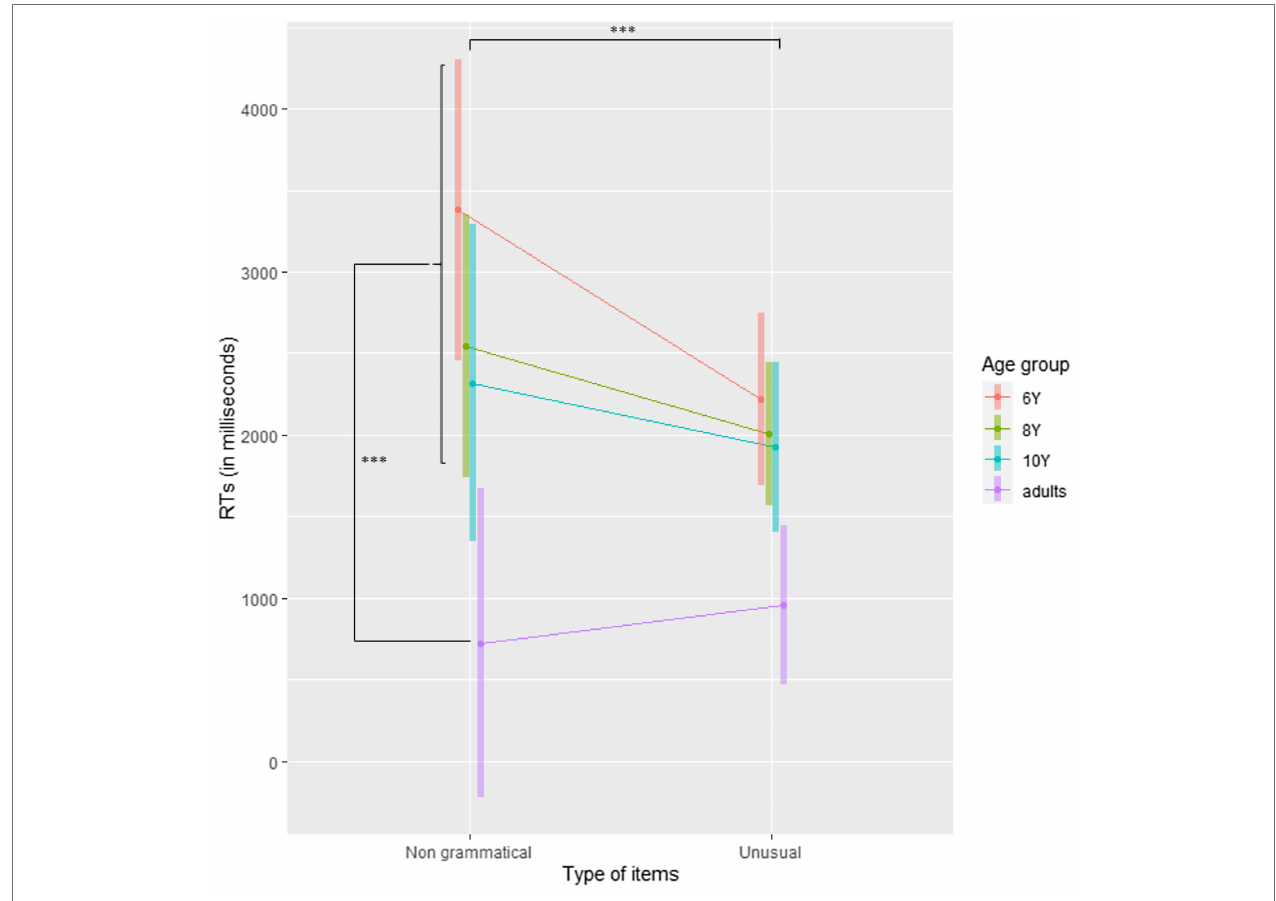
FIGURE 6 | Mean RTs plotted separately for Age group and Type of item for “ungrammatical” responses in Experiment 2. Error bars are 95% CI. *** p <